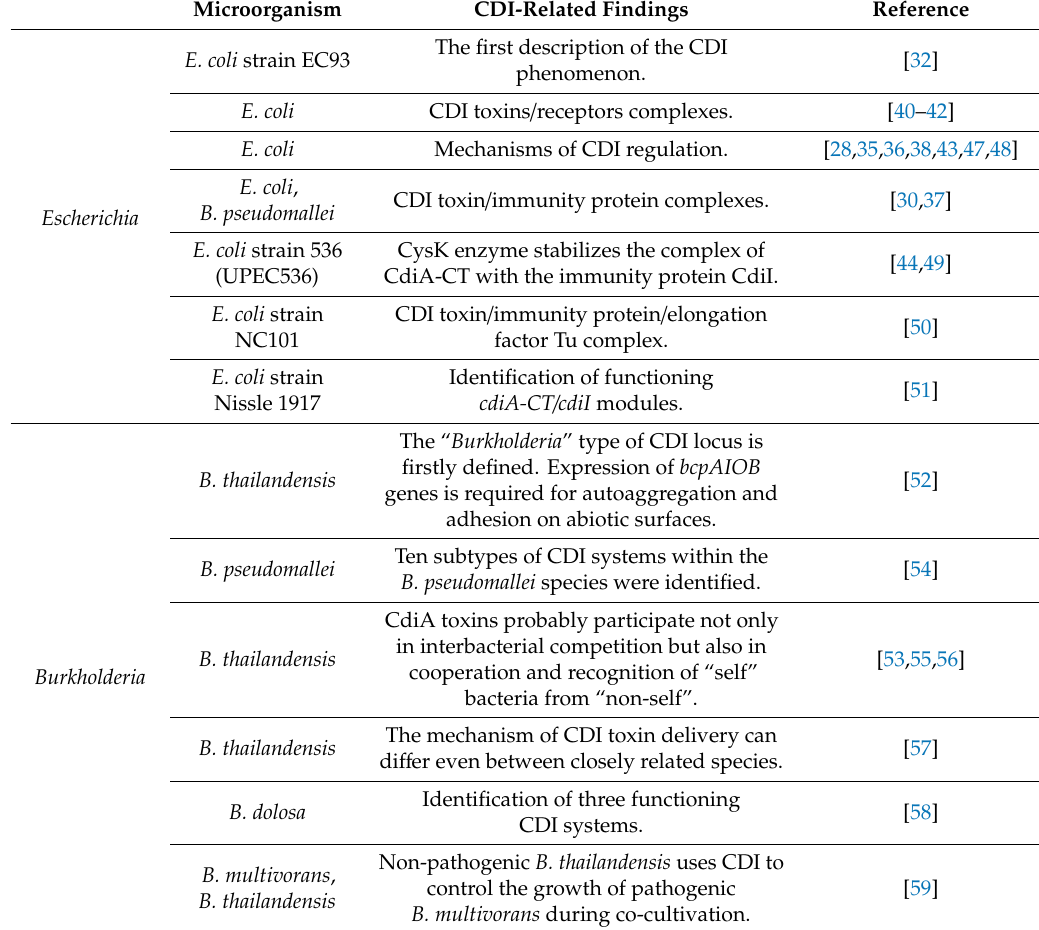
Table 1. CDI systems in bacterial